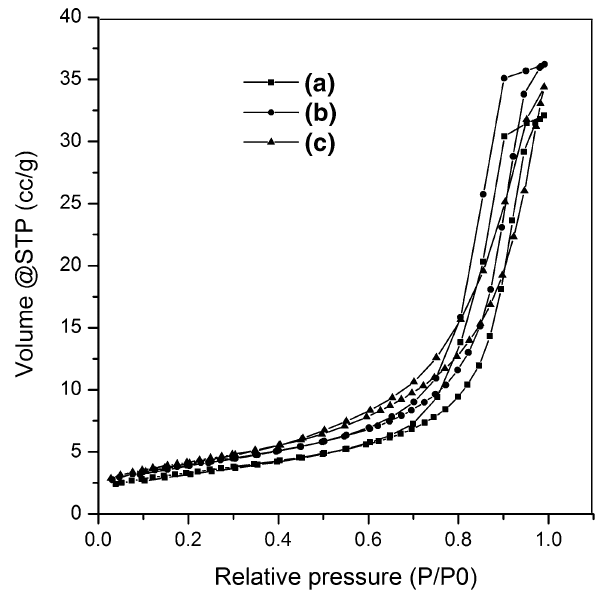
Fig. 9 Isotherm adsorption–desorption of sulfated zirconia with different ratios Zr/CTAB. a 1:1, b 3:1, and c